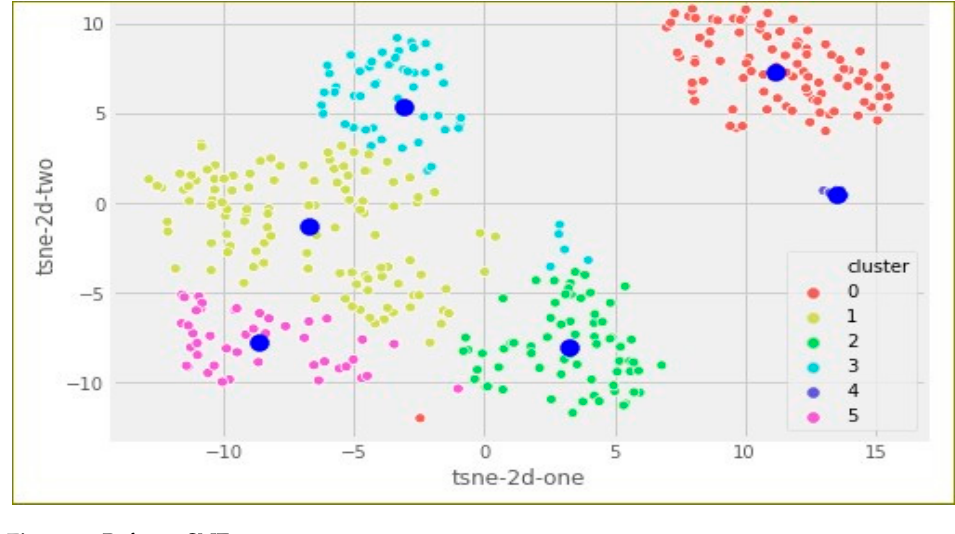
Figure 8. Before t-SNE .